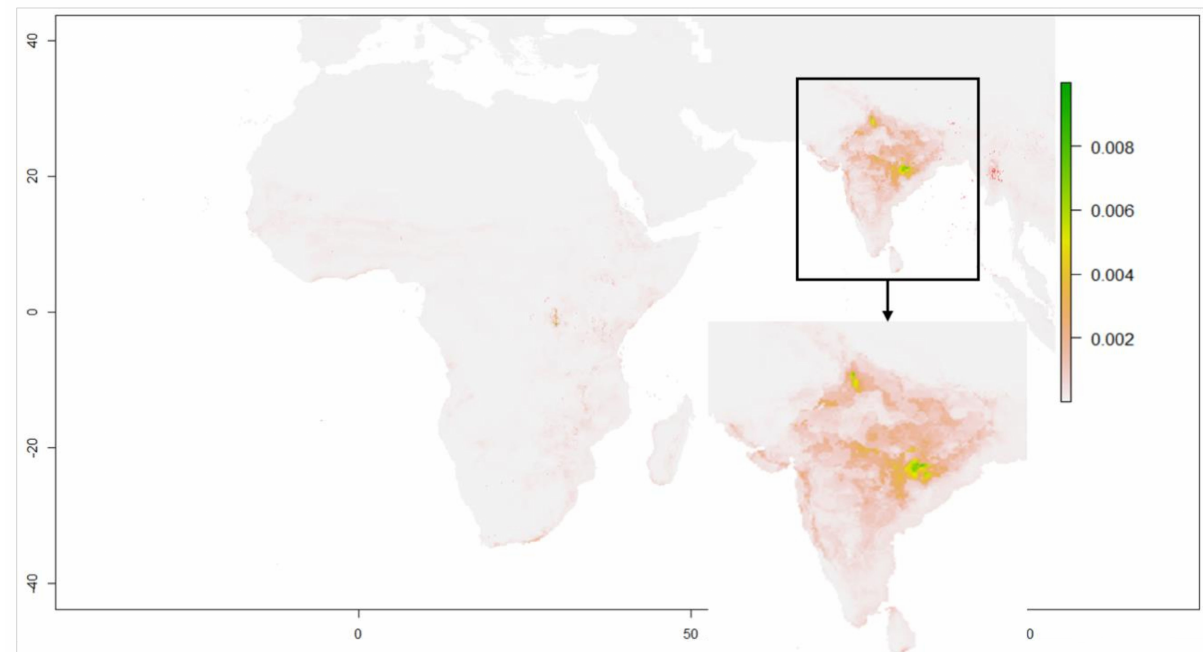
Figure 4. Habitat suitability modelling in 1991–2005 for the June–September period.